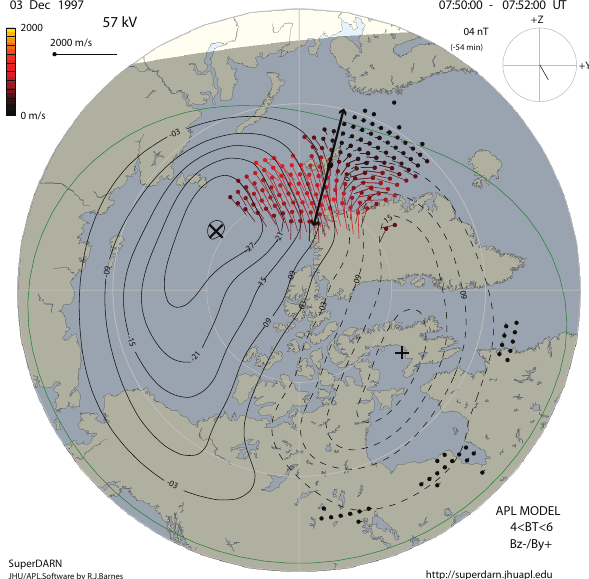
Fig. 9. SuperDARN convection data for 08:40–08:42UT. Same for- mat as in Fig. 8.